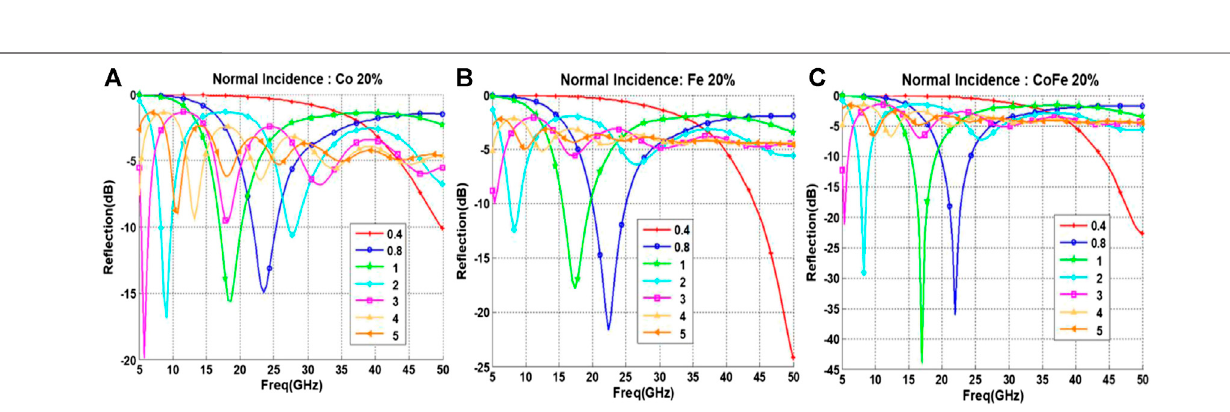
Frontiers in Materials |